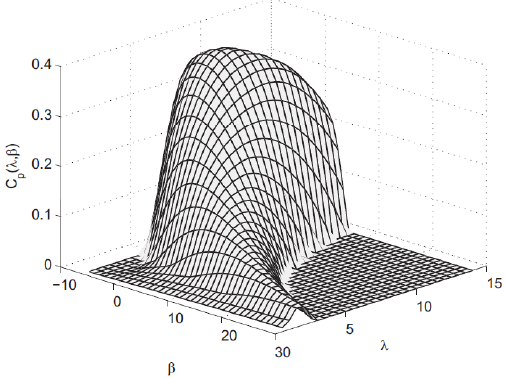
Figure 2. Power coefficient curve of the WT